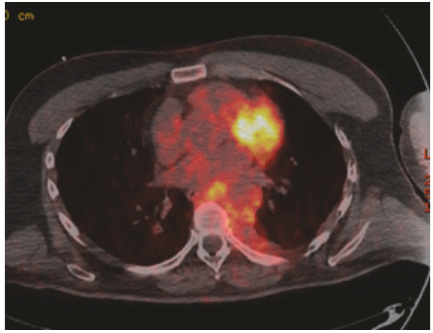
Figure 2: Baseline PET Scan following one course of chemotherapy showing metabolic activity in the mass. Note after clarification from nuclearmedicineradiologist:myocardialuptakeispresentaspatient did not comply with 6-hour glucose fasting prior to